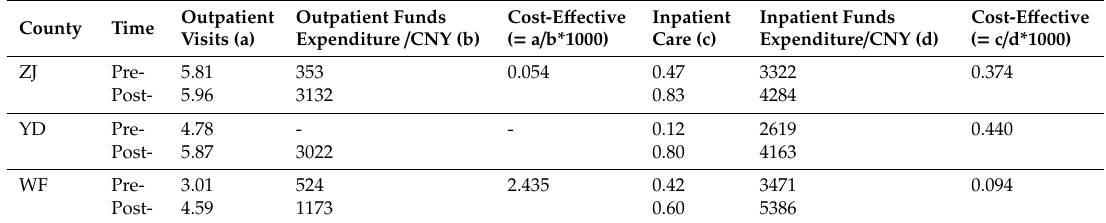
Table 2. The pre-post health utilizations and cost-e ff ectiveness of tuberculosis (TB) patients by counties. County